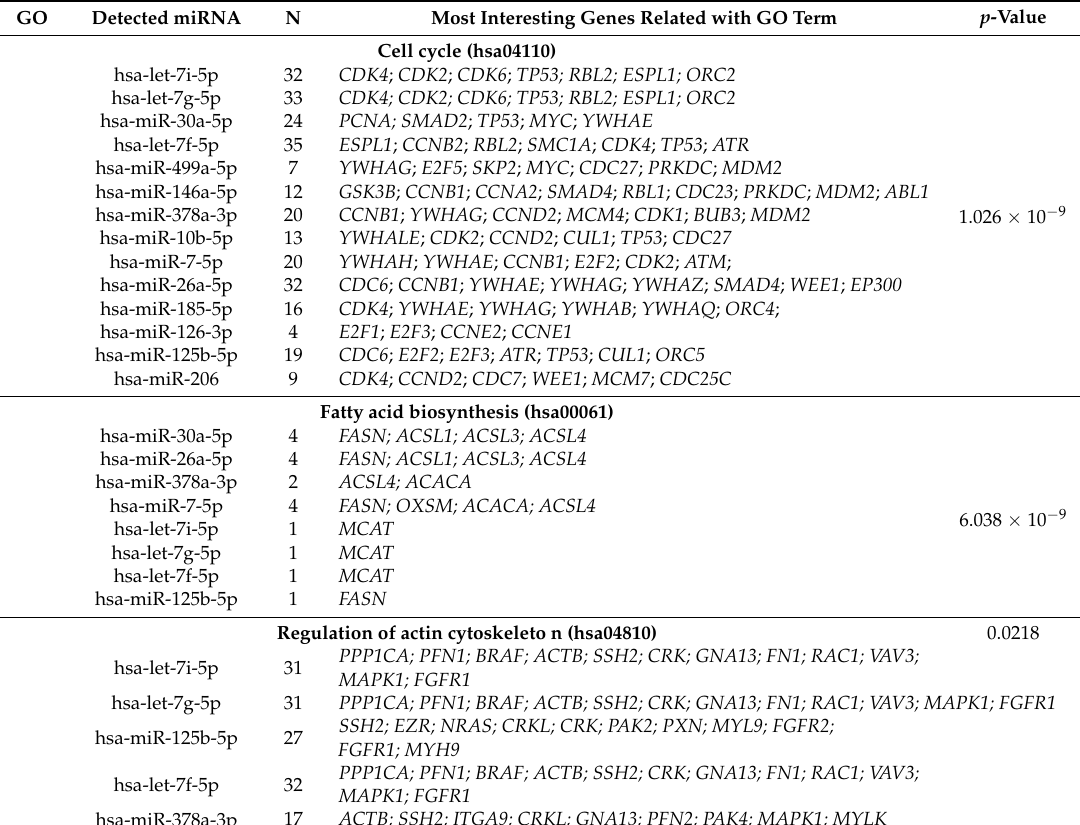
Table 2. The detected significant Gene Ontology terms based on miRNAs differentially expressed between pigs differing in terms of muscle